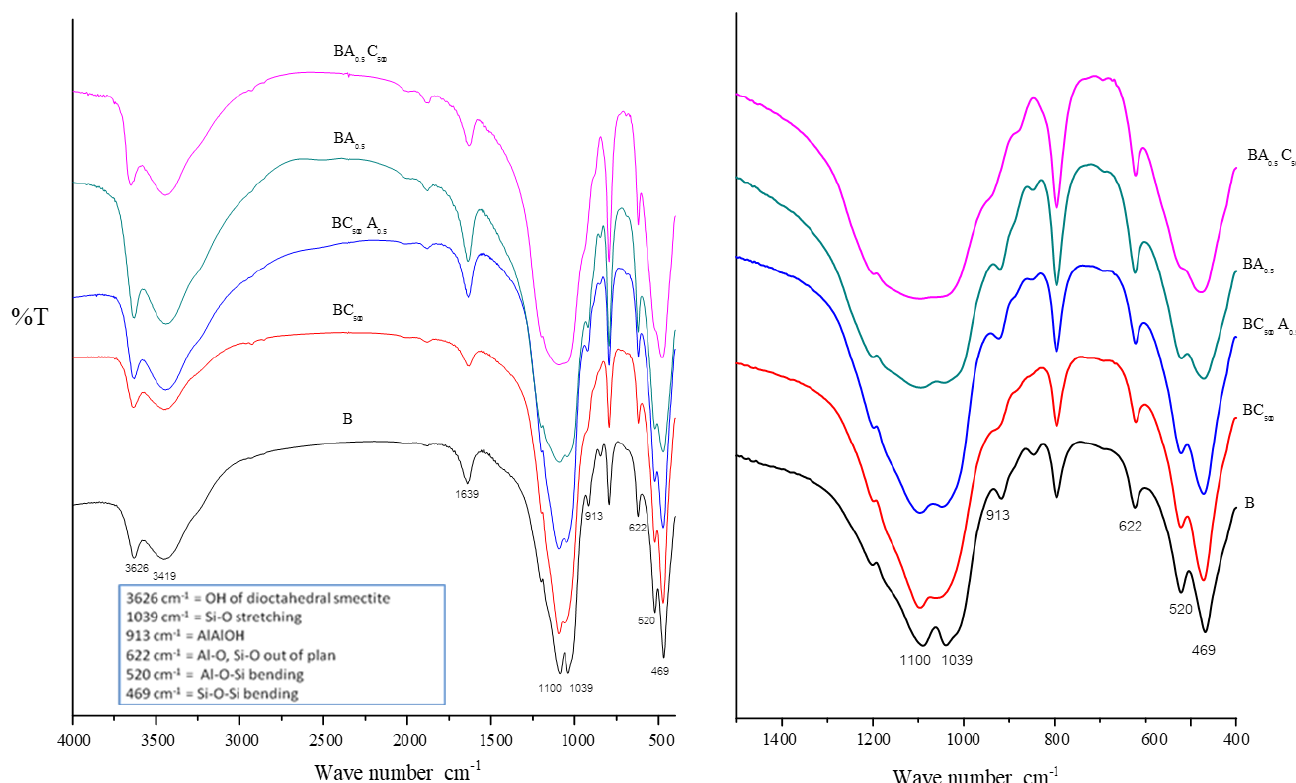
Figure 2. Mid FT - IR spectra of bentonite (B), BC 500 , BC 500 A 0.5 , BA 0.5 and BA 0.5 C 500 samples.